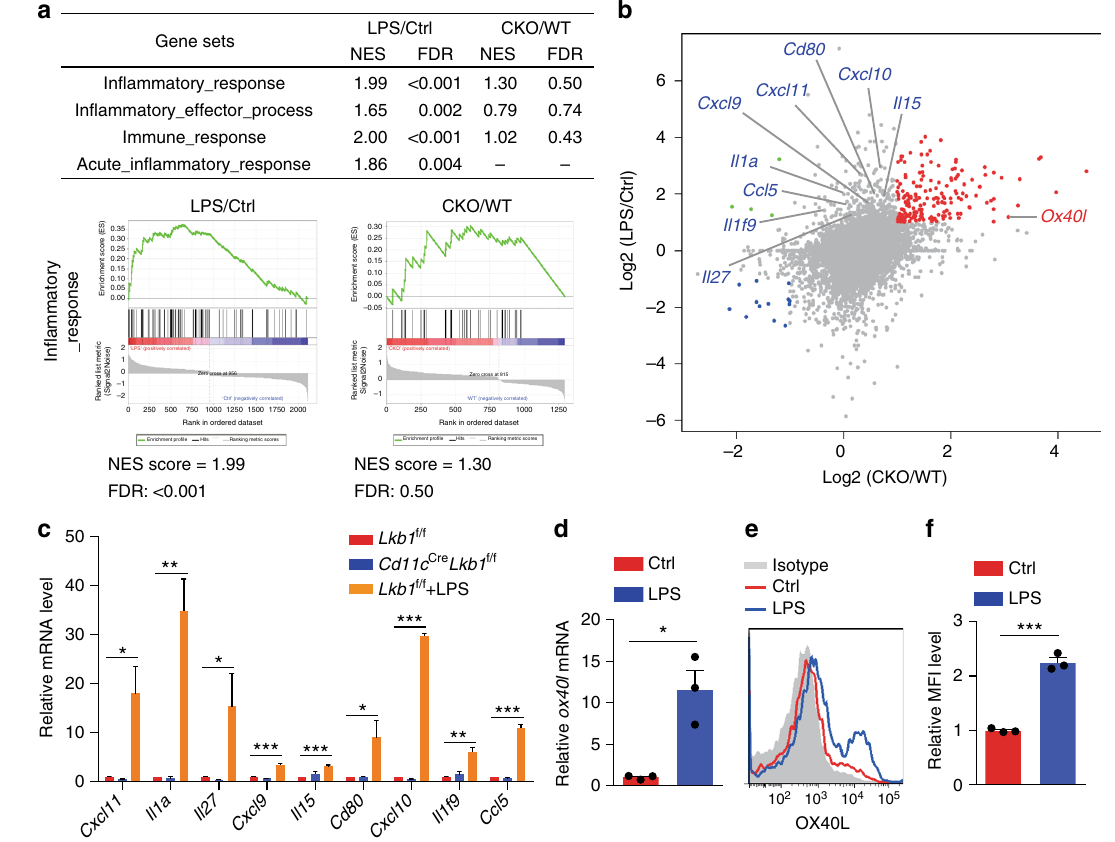
Fig. 8 Lkb1 discriminates regulatory from in fl ammatory transcriptional programmes. a GSEA of transcriptional pro fi les of DCs from mice treated with LPS compared with that of Cd11c Cre Lkb1 f/f mice. The upper part shows the list of gene sets related to in fl ammation; the lower part shows a representative plot of the gene set; – , no enrichment. b Scatter plot of Log 2 counts of the genes expressed in splenic DCs from Lkb1 f/f mice treated with LPS ( n = 1) compared with those from Cd11c Cre Lkb1 f/f mice ( n = 3). Grey dots mark genes with less than two-fold change in any group. Red and blue dots mark the positively correlated genes with more than two-fold change from the two groups, while negatively correlated genes are indicated in green. The names of pro- in fl ammatory genes only upregulated in LPS-treated DCs are indicated in blue characters, and Ox40l , upregulated in both groups, is indicated in red characters. c mRNA levels of Cxcl11, Il1a, Il27, Cxcl9, Il15, Cd80, Il1f9, Cxcl10 and Ccl5 in splenic DCs from Lkb1 f/f mice, Lkb1 f/f mice treated with LPS, and Cd11c Cre Lkb1 f/f mice. d mRNA level of Ox40l in DCs sorted from mice treated with or without LPS. e , f Flow cytometric analysis ( e ) and quanti fi cation of relative MFI ( f ) of OX40L protein expression on splenic DCs from mice treated with or without LPS (1.5 mg kg − 1 ). The results are presented as the mean